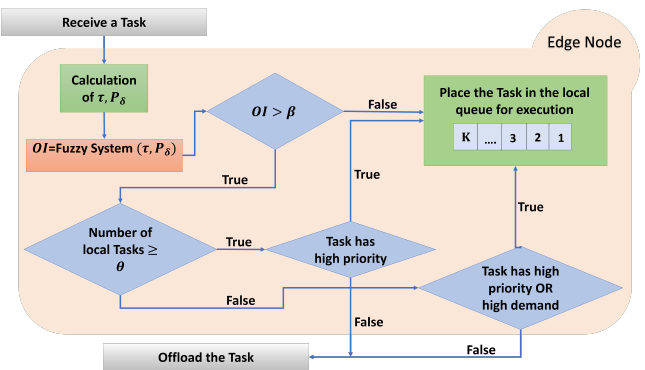
Figure 1. Proposed model adapted to an edge node.